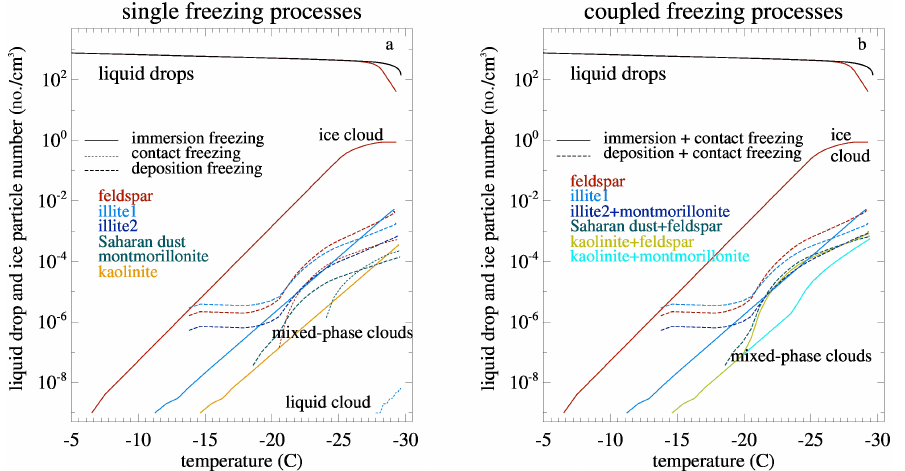
Figure 12. Total numbers of liquid drops and ice particles as a function of temperature for single and coupled freezing processes that are marked by different line styles. Types of INP marked by colors. Model simulations with average continental number size distribution and with (cid:49)T = 2K. Numbers concentrations per cm 3 as a function of